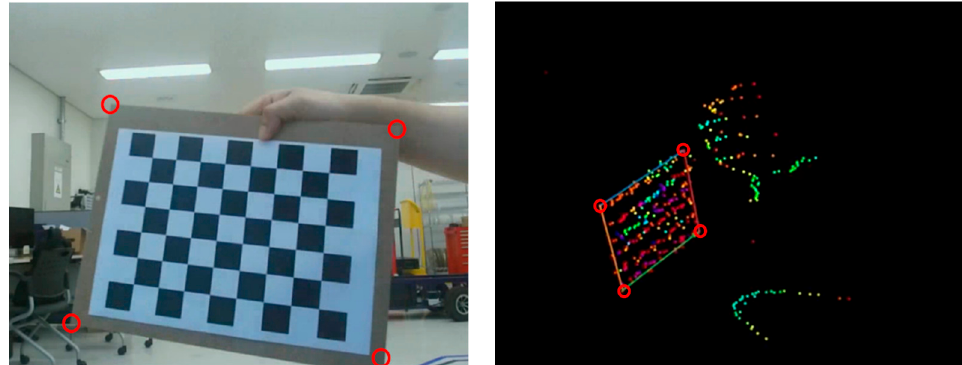
Figure 8. Corresponding points by selecting the four corner points of the checkerboard.